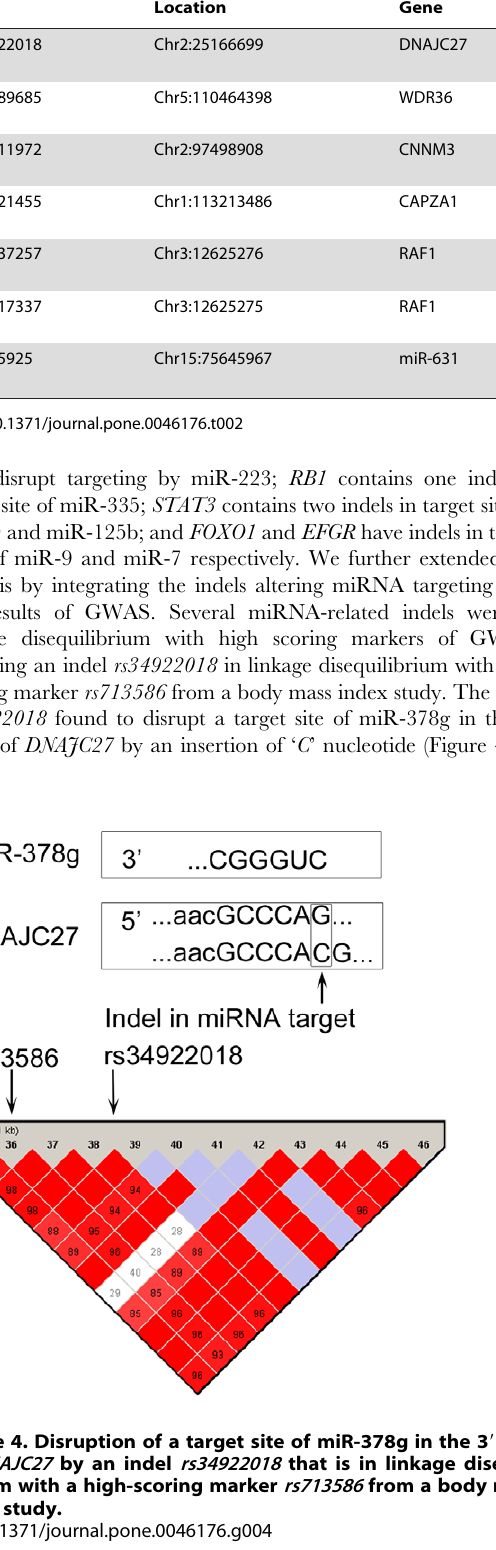
miRNA or Target Gene